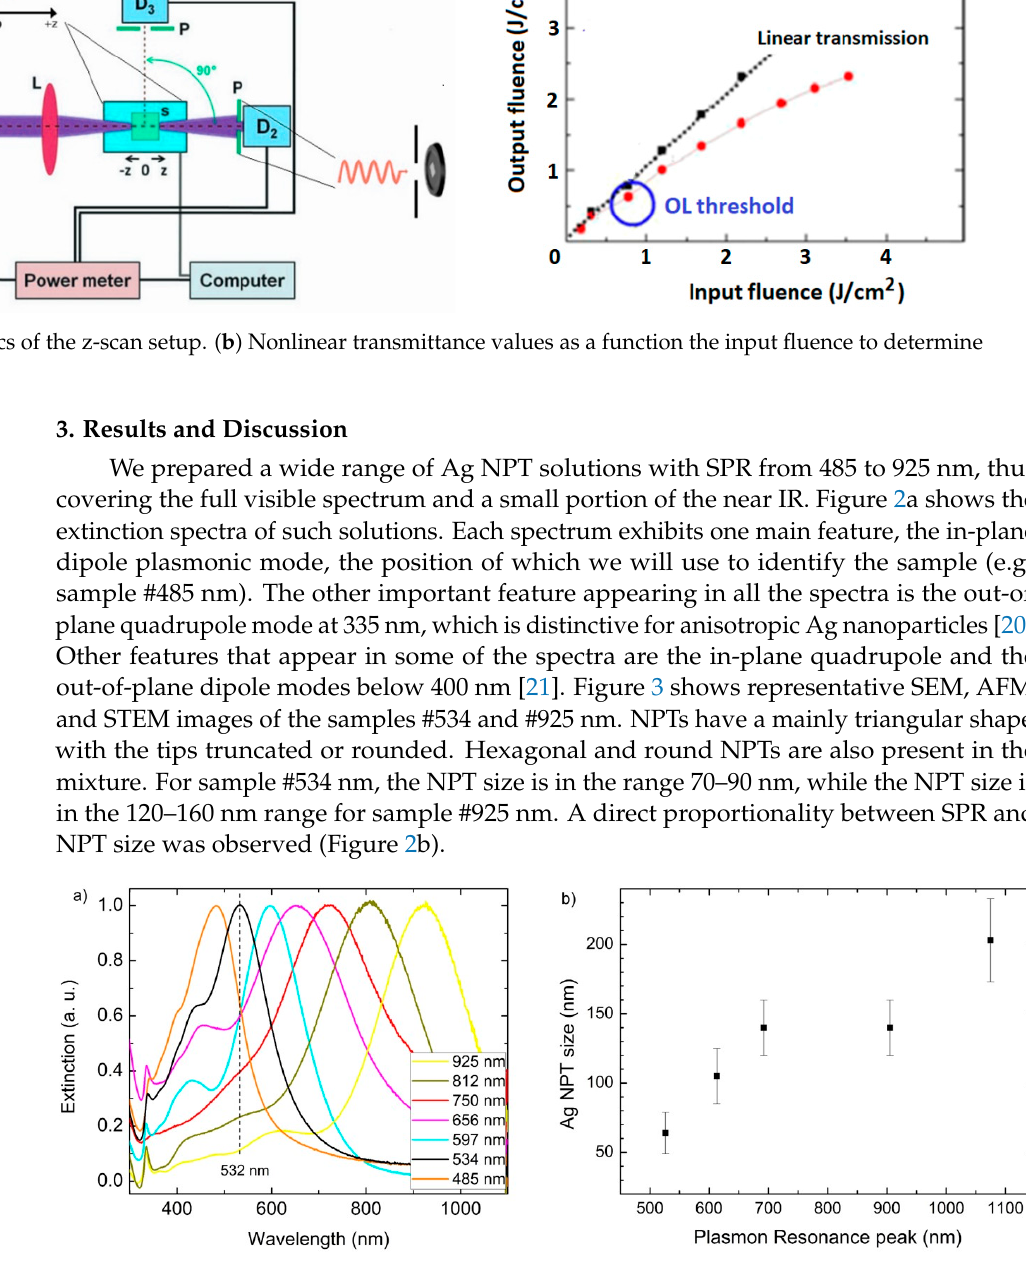
Figure 2. Optical absorption spectra from Ag NPT solutions prepared by seed-mediated growth and tested for NLO properties (a); SPR vs. NPTs size measured using AFM (b).